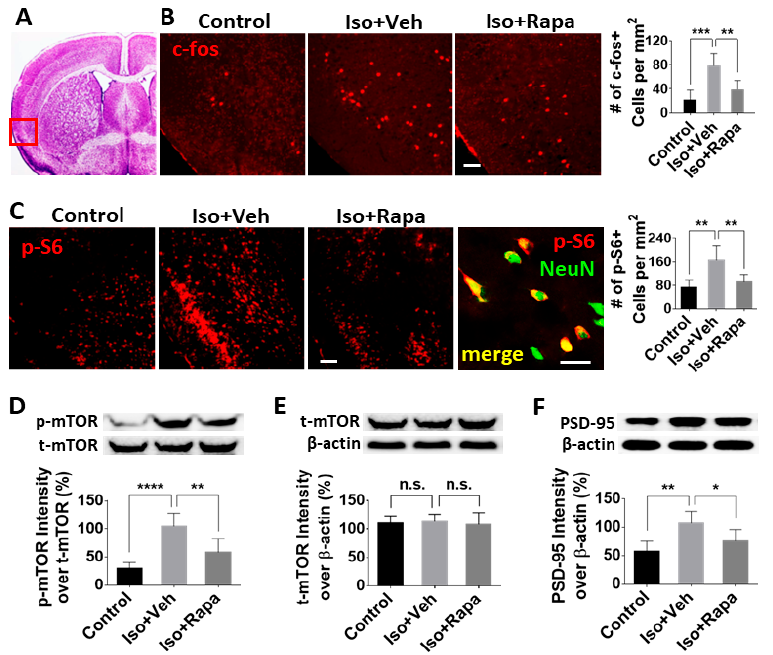
Figure 2. E ff ect of isoflurane exposure on neuronal activity in the insular cortex (IC). ( A ) Representative coronal brain section. The red box indicates the location in Figures B and C. ( B ) Immunohistochemical (IHC) image. Early isoflurane exposure resulted in dramatic increase in number of c-fos-labeled neurons in IC, and rapamycin injection reversed this e ff ect. Bar = 50 µ m. The histogram showed quantitative results. ( C ) The number of phospho-s6 (pS6) positive cells in isoflurane-exposed mice was revealed to be greater than in the control. Notice the dramatic increase of pS6 positive cells in layer 3. Rapamycin injection decreased this number. Bar = 100 µ m. The high-power double IHC image for pS6 and NeuN indicated that these pS6 positive cells in IC were neurons. Bar = 50 µ m. Graph showed quantitative results. ( D ) The mammalian target of rapamycin (mTOR) phosphorylation was examined with WB using IC tissue. The ratio of band intensity of phosphorylated mTOR (p-mTOR) over total mTOR (t-mTOR) was dramatically elevated by isoflurane exposure and a recovery resulted from rapamycin treatment. ( E ) Isoflurane exposure and rapamycin injection did not alter the level of total mTOR in IC. ( F ) Expression of post-synaptic density 95 (PSD95) in IC. WB shows the ratio of PSD95-positive bands over β -actin was significantly upregulated by isoflurane and returned to near control levels with rapamycin treatment. Statistics for all tests in this figure were one-way ANOVA. Iso: isoflurane; Veh: vehicle; Rapa: rapamycin. n.s.: no significance; *: p < 0.05; **: p < 0.01; ***: p < 0.001. Error bars: SD.